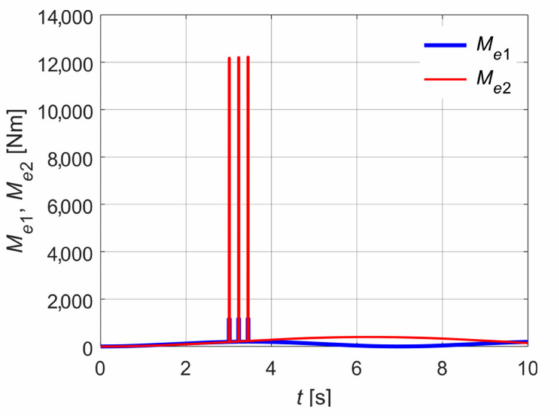
Figure 5. Moments interfering as a function of time affecting ARS from the base side.